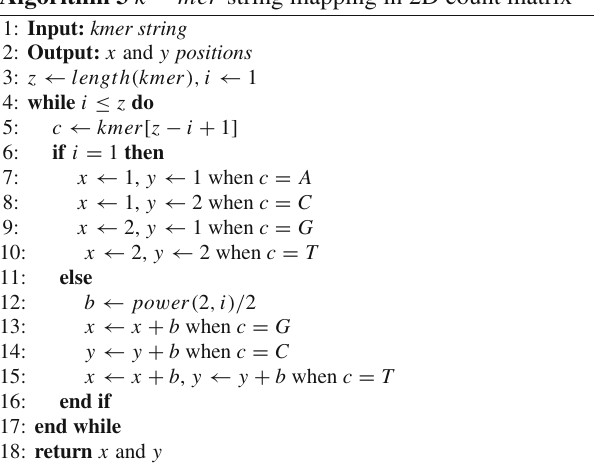
Fig. 2 Two-dimensional k − mer count matrix where each cell represent a number of count of a specific subset in the whole string a 1 − mer has 4 count cells for the subset with one base, b 2 − mer contains 16 count cells for subset comprising of two bases, c 3 − mer has 64 count cells where each subset is comprised of 3 bases or a codon, d general expansion formula for k length subset or k − mer . Here, four red color cells in ( b ) indicate that it is expanded from one red cell in ( a ), again, 16 red cells in ( c ) indicate that it is expanded from red cells of ( b )